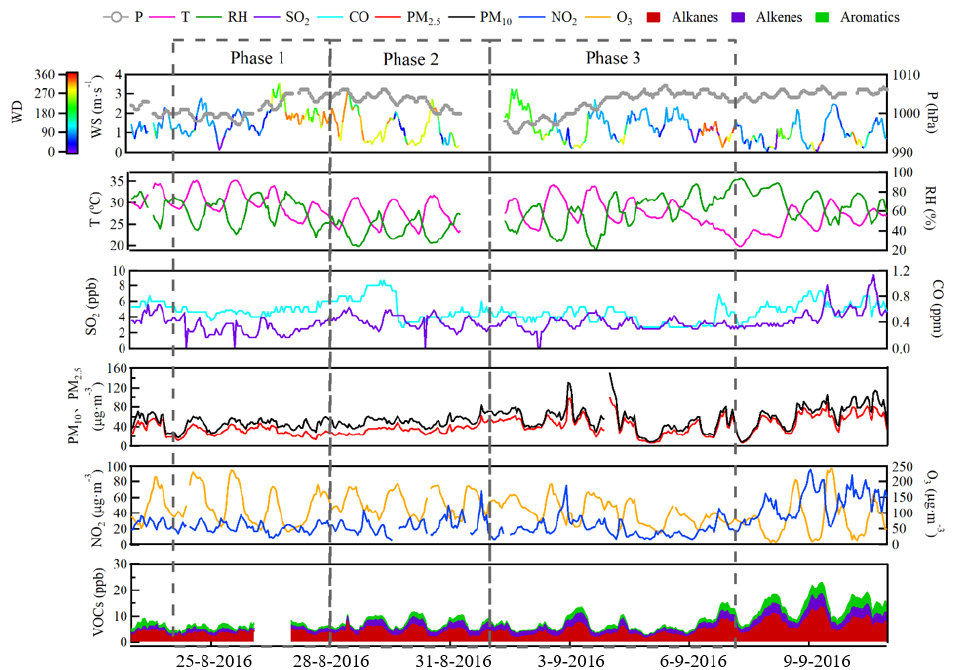
Figure 3. Time series of meteorological parameters (pressure, wind speed, wind direction, temperature and relative humidity) and pollutants (SO 2 , CO, PM 10 , PM 2.5 , O 3 , NO 2 and VOCs) measured at the ZH site.